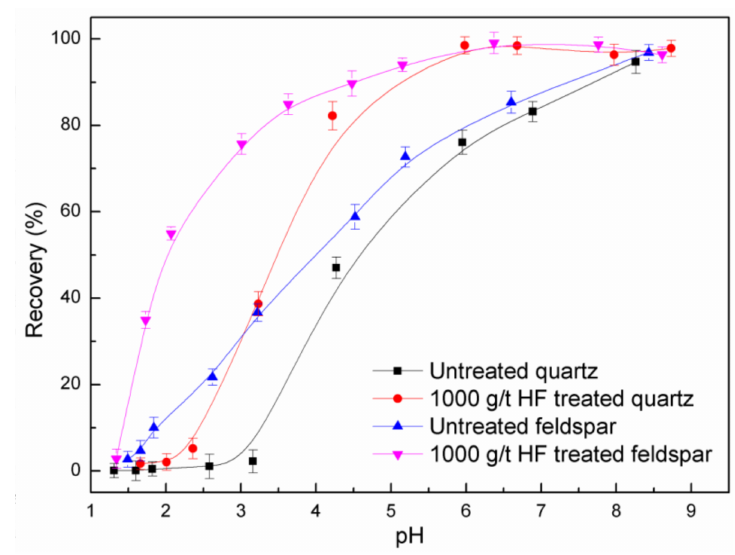
Figure 2. Flotation recovery of feldspar and quartz as a function of pH ( C DDA = 2.0 × 10 − 4 M). The flotation recovery of feldspar and quartz at pH 2, as a function of concentrations of HF pretreatment and DDA, is shown in Figure 3. Under the same concentration of DDA, the flotation recovery of feldspar increased with HF pretreatment concentration. Under the same concentration of HF pretreatment, the floatability of feldspar increased with DDA concentration, and the flotation recovery did not increase further when the DDA concentration was ~5 × 10 − 4 M. Comparing the effect of HF pretreatment with that of non-treatment, the flotation recovery of quartz showed a smaller change than that of